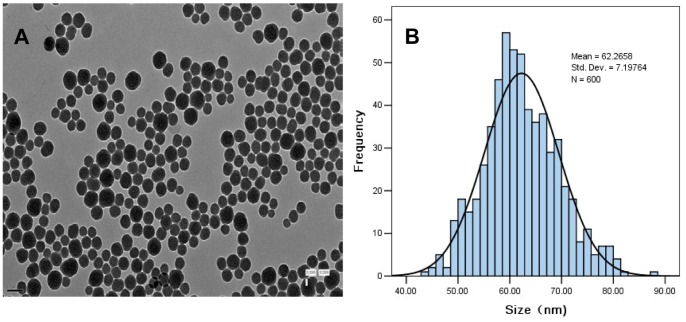
Characterization of silica nanoparticles.(A) Transmission electron microscopy image. (B) Size distribution. Silica nanoparticles exhibited good monodispersity and showed approximately normal distribution.